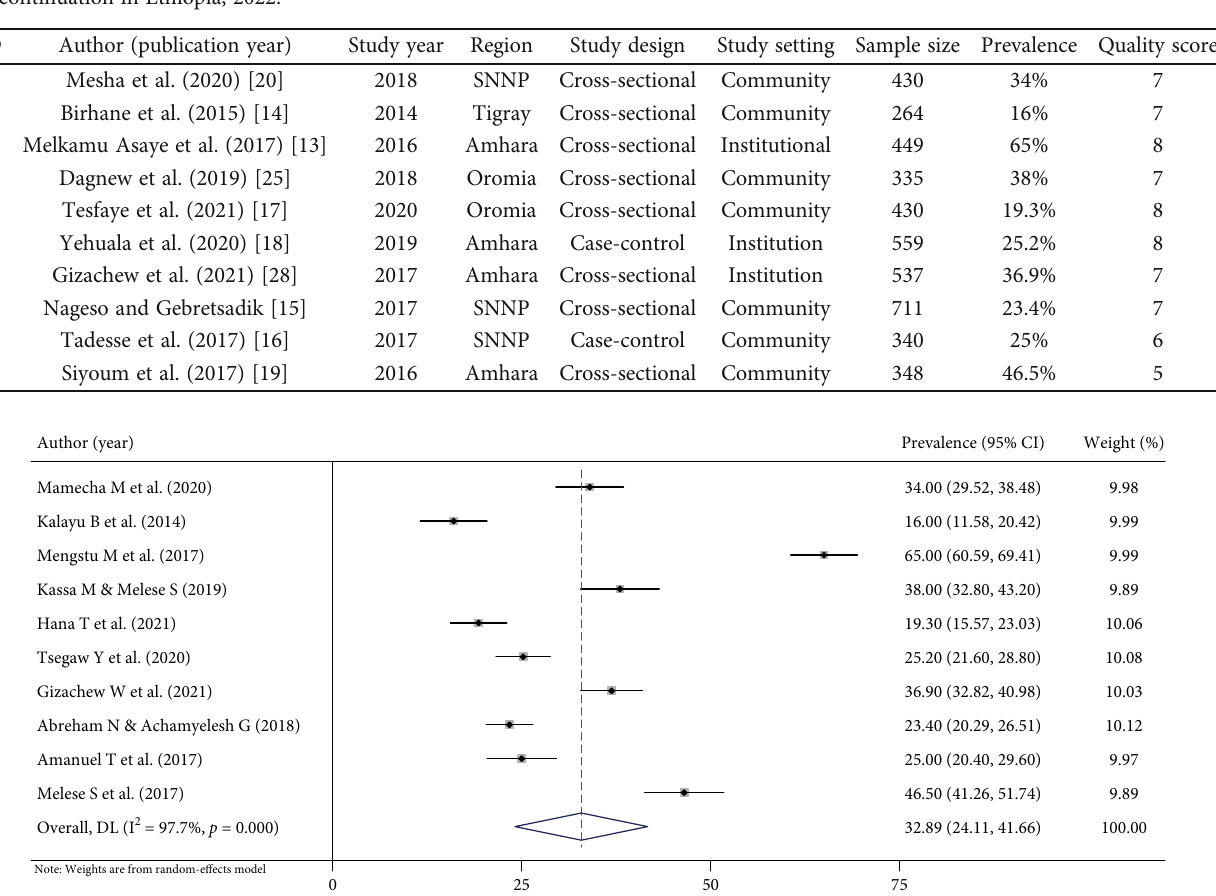
Figure 2: Forest plot for the pooled prevalence of Implanon discontinuation among reproductive age women, a systematic review and meta- analysis, Ethiopia, 2022.